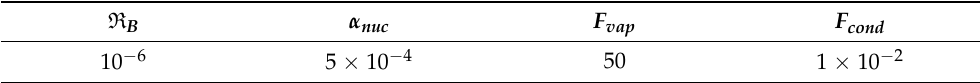
Table 1. ZGB cavitation model coefficient [18]. R